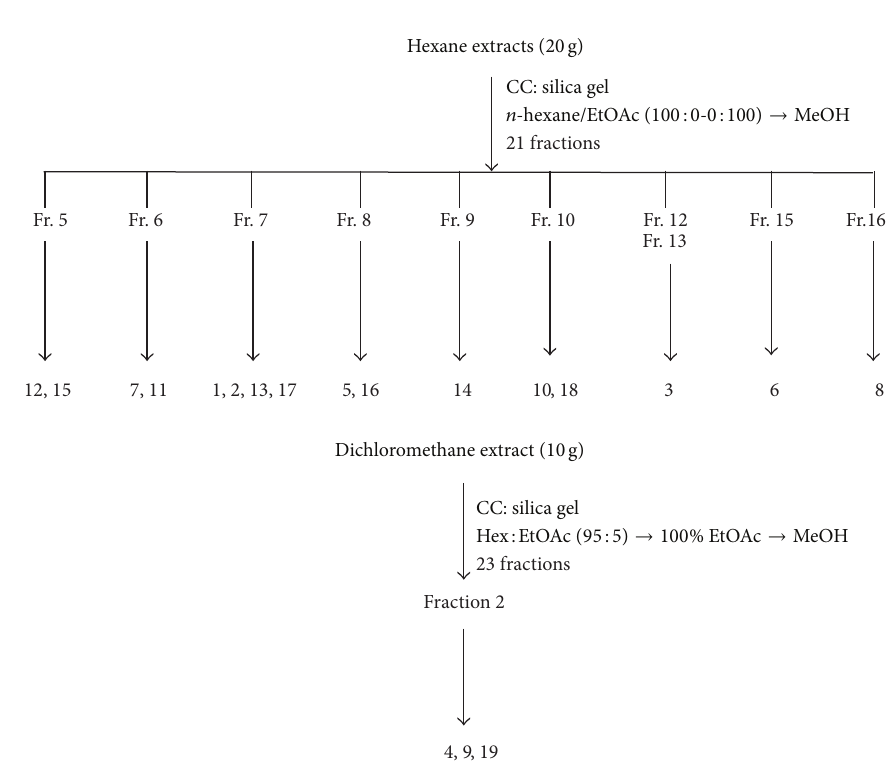
Figure 2: Schematic represents the isolation method of the bioactive compounds from Curcuma zedoaria .